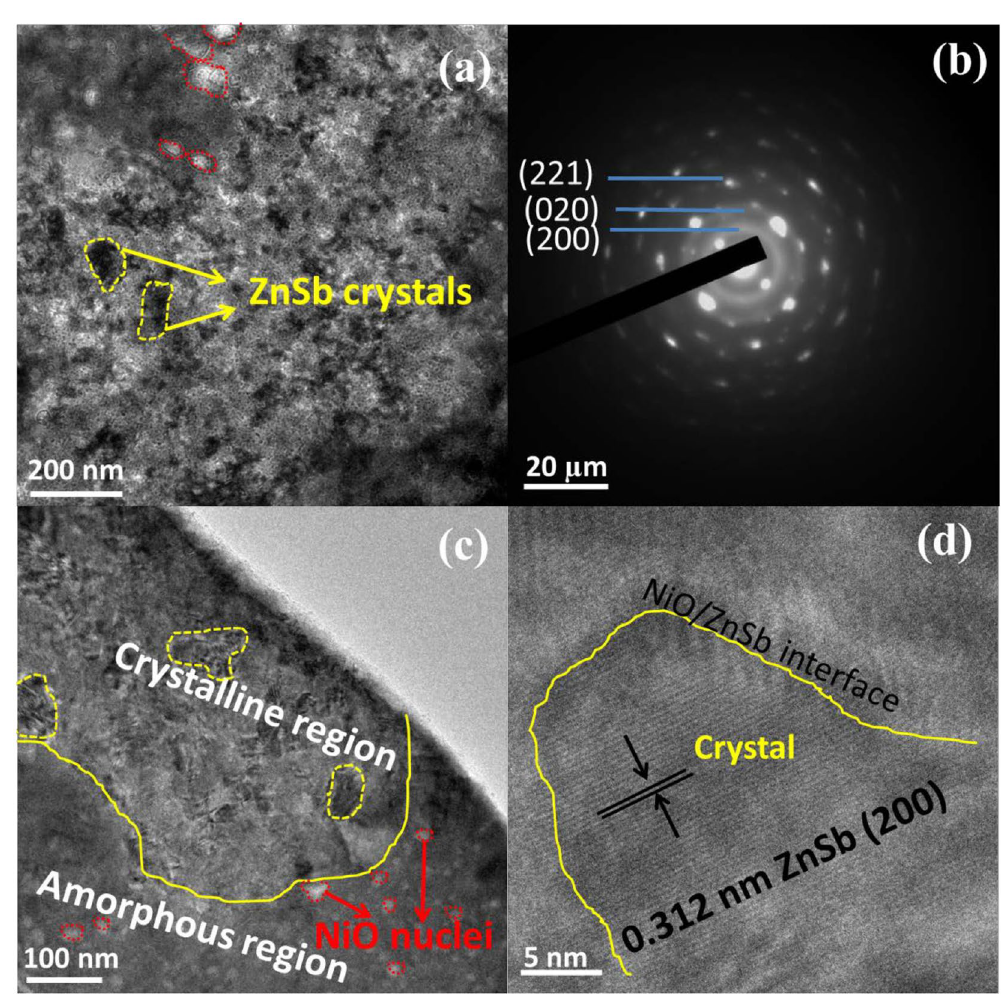
Figure 6. ( a ) The bright field TEM image, ( b ) the SAED pattern ( c ) the cross-section bright filed TEM image and ( d ) the HRTEM image of the NiO-doped ZnSb film annealed at 350